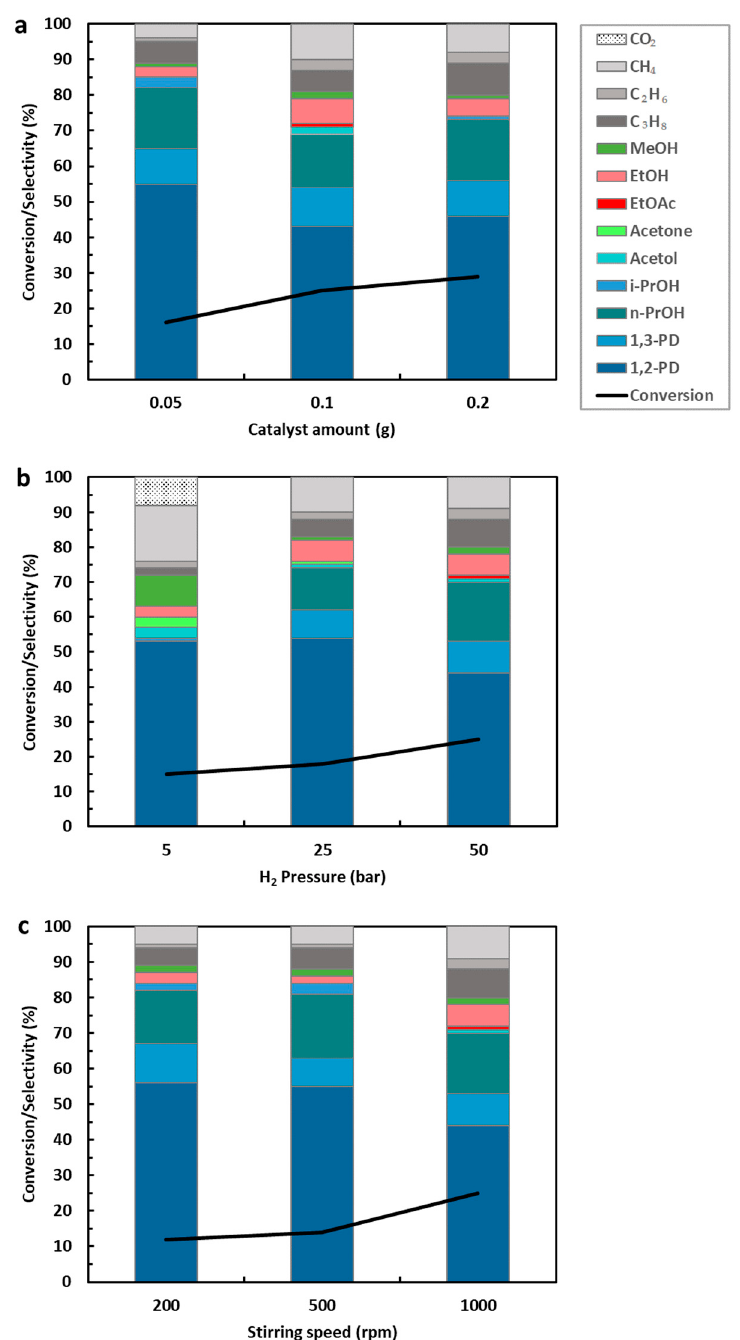
Figure 3. GL conversions and product selectivities with different ( a ) catalyst amount, ( b ) H 2 pressure, and ( c ) stirring speed. General reaction conditions: 1.0 g GL (11 mmol) (corresponding to 10 wt.%), 0.05–0.2 g Ru-WD (0.01–0.04 mmol Ru), 10 mL H 2 O, 5–50 bar H 2 , 200 °C, 24 h, 200–1000 rpm.